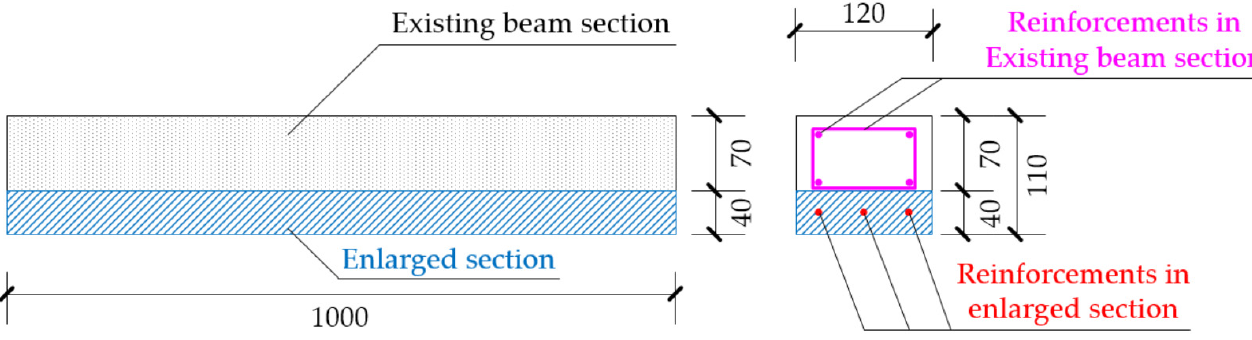
Figure 1. Specifications of the test specimens.